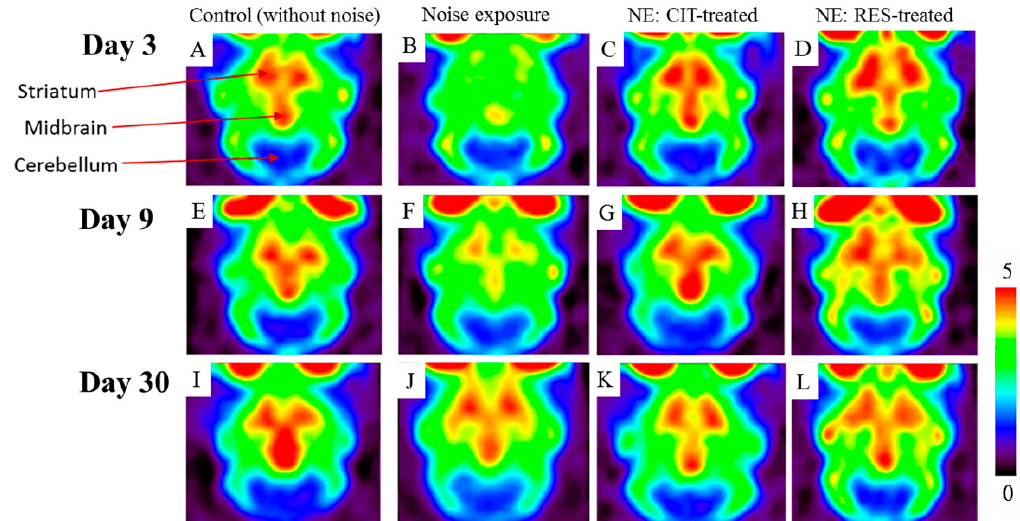
Figure 2. 4-[ 18 F]-ADAM/small-animal PET images of transverse sections are displayed. Images were acquired from the control group ( A , E , I ), NE group ( B , F , J ), CIT-treated group ( C , G , K ), and RES- treated group ( D , H , L ) on day 3 ( A – D ), day 9 ( E – H ), and day 30 ( I – L ). The PET images from the NE group clearly portray less 4-[ 18 F]-ADAM uptake relative to the other groups on days 3 and 9. The color scale for all images was adjusted by the standardized uptake value of cerebellum as reference region. The standardized uptake value ratio is the unit of the color scale (0~5). (CIT: citalopram, RES: resveratrol, NE: noise exposure, PET: positron emission tomography).